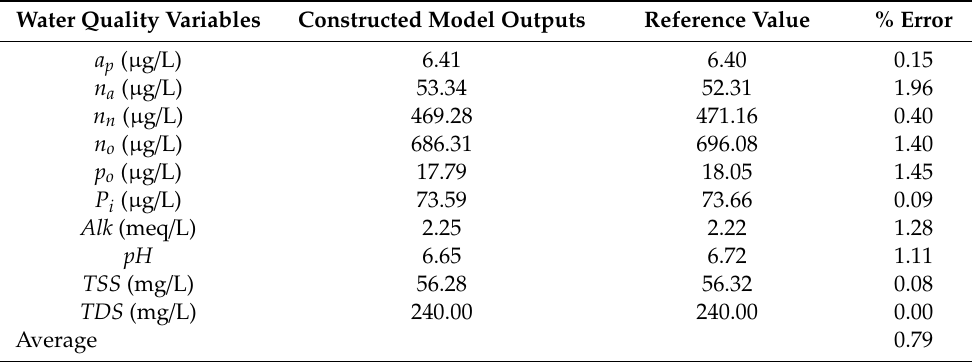
Table 7. Calibration with Qual2k for side slopes 0 (rectangular cross